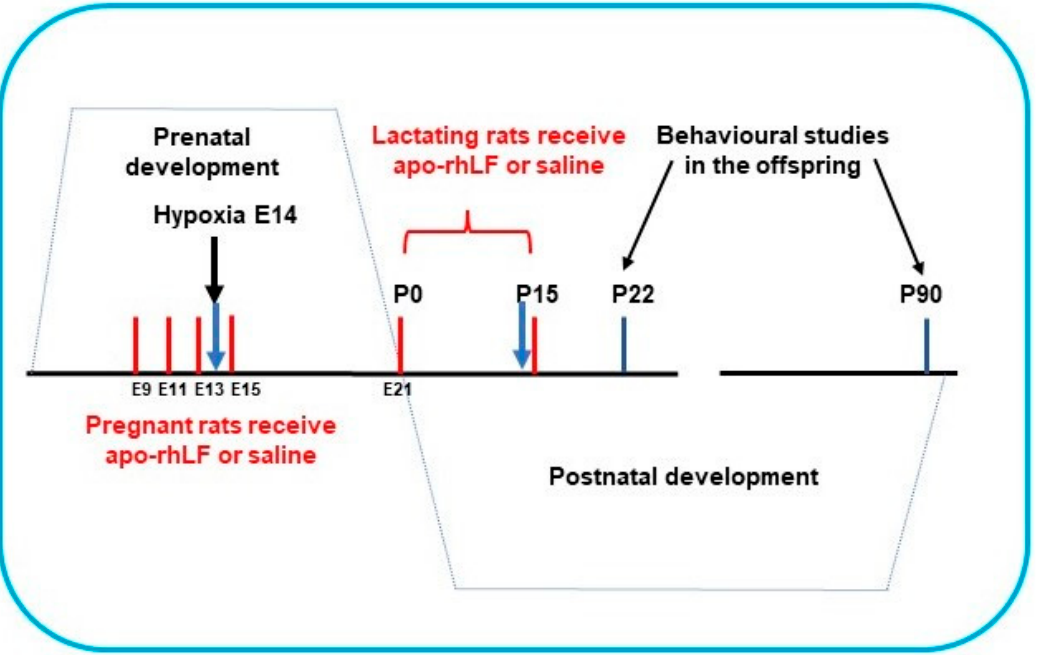
Figure 1. The scheme of apo-rhLF administration to pregnant and lactating rats. Red lines—days of apo-rhLF administration to pregnant or lactating rats. Blue arrows mark the periods of collecting the material for Western blotting (E14 and P14).